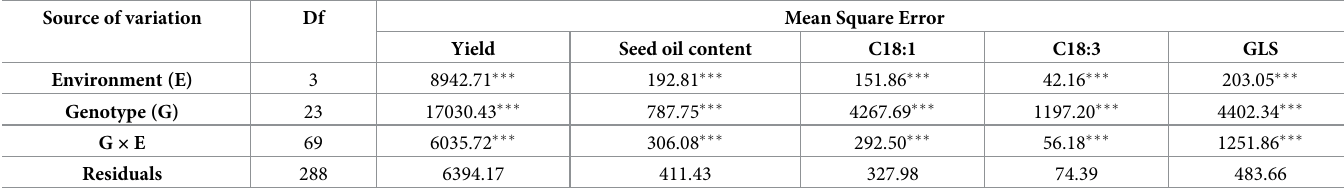
Table 3. Variance estimates for seed yield, seed oil content and for seed